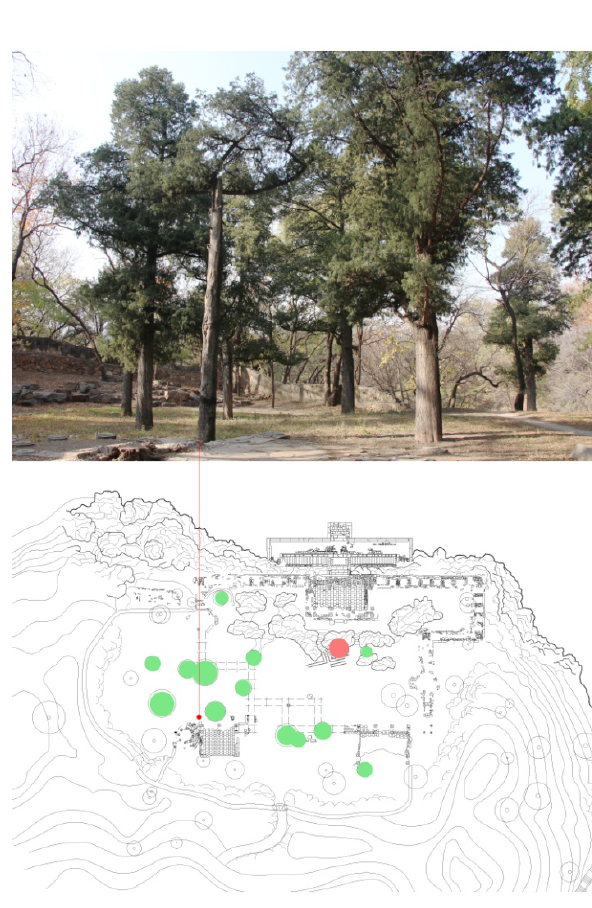
Figure 9. The old trees in the Qiwang Hall